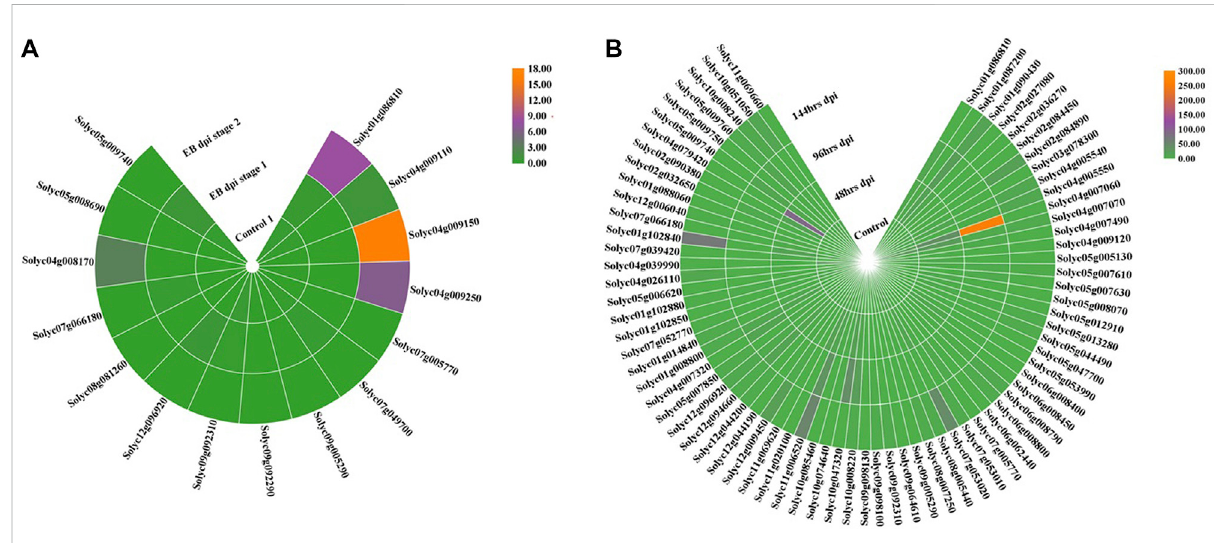
FIGURE 6 RNA-seqexpressionpro fi leofDEGsfromthe NLR genefamilyintomatoleaftissueundercontrolanddiseaseconditionsinearly (A) andlate (B) blight shown in hours after inoculation. Orange: higher transcriptomic abundance; green: low transcription